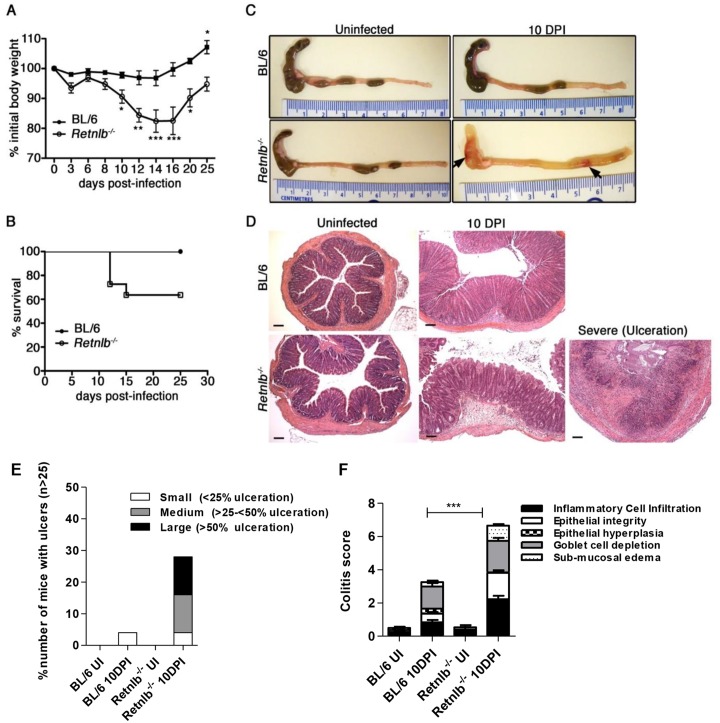

Retnlb
-/- mice are highly susceptible to C. rodentium-induced colitis.(A) Body weights following infection of C57BL/6 and Retnlb
-/- mice. Error bars = SEM. *P < 0.05; * P < 0.05 *** P < 0.0001 (vs. 0 DPI). Results are representative of at least 3 experiments, n = 3–6/group. (B) Infection survival curve of C57BL/6 mice and Retnlb
-/- mice. Starting numbers (i.e at 0 DPI) were WT, n = 9; and Retnlb
-/-, n = 11. Results are representative of 3 experiments. (C) Resected colons and ceca of uninfected and 10 DPI C57BL/6 and Retnlb
-/- mice. Results are representative of ≥ 4 infections, n = 3–6/group. (D) Representative H&E-stained colon sections from C57BL/6 and Retnlb
-/- mice at 10 DPI (n ≥10/group). (E) Ulcer frequency and size in C57BL/6 vs. Retnlb
-/- mice at 10 DPI. Bars show average mean values of ≥ 3 independent experiments, each with n = 2–4 mice/group. (F) Histopathology scoring of C57BL/6 vs. Retnlb
-/- mice (n ≥ 10 per group). *** P < 0.0001. All error bars = SEM.